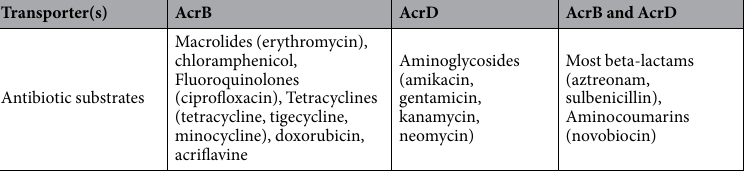
Table 1. Antibiotic substrate specificities of the paralog RND transporters AcrB and AcrD from E. coli 22, 25, 46, 80–84 . Classes of compounds are indicated, with examples of specific compounds within parentheses (2D chemical structures of these compounds are shown in Supplementary Figure S3).